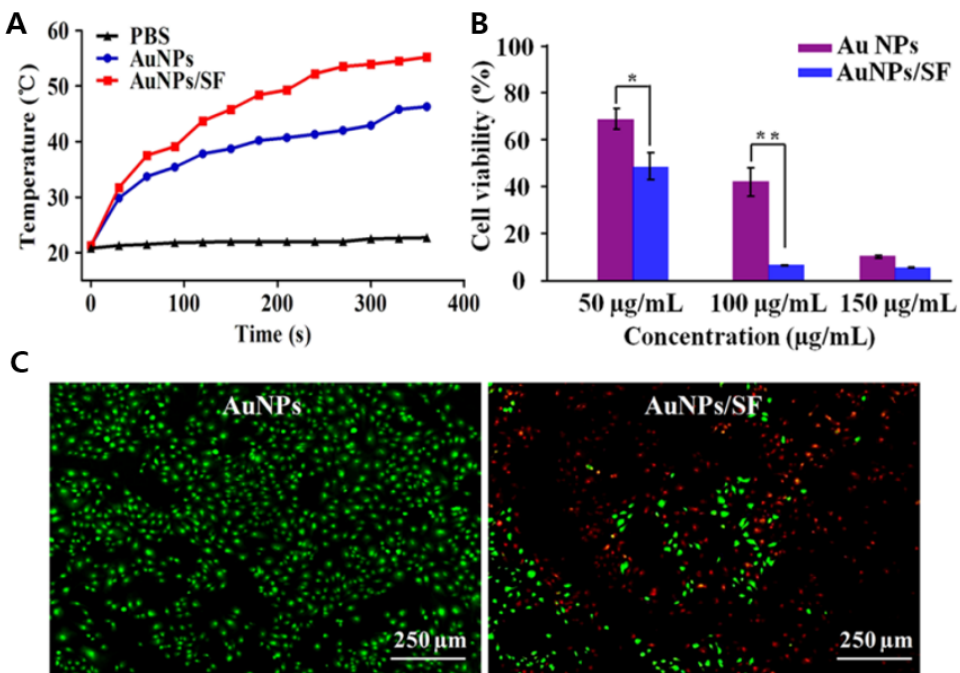
Figure 5. AuNP/silk fibroin hybrid (AuNP/SF) for use in PTT. ( A ) Temperature comparison using AuNPs and AuNP/SF. ( B ) Cell viability after AuNP or AuNP/SF uptake at various concentrations. ( C ) MCF-7 cell images before and after laser irradiation in the presence of AuNPs or AuNP/SF. Reproduced with permission from [106] . American Chemical Society, 2019.